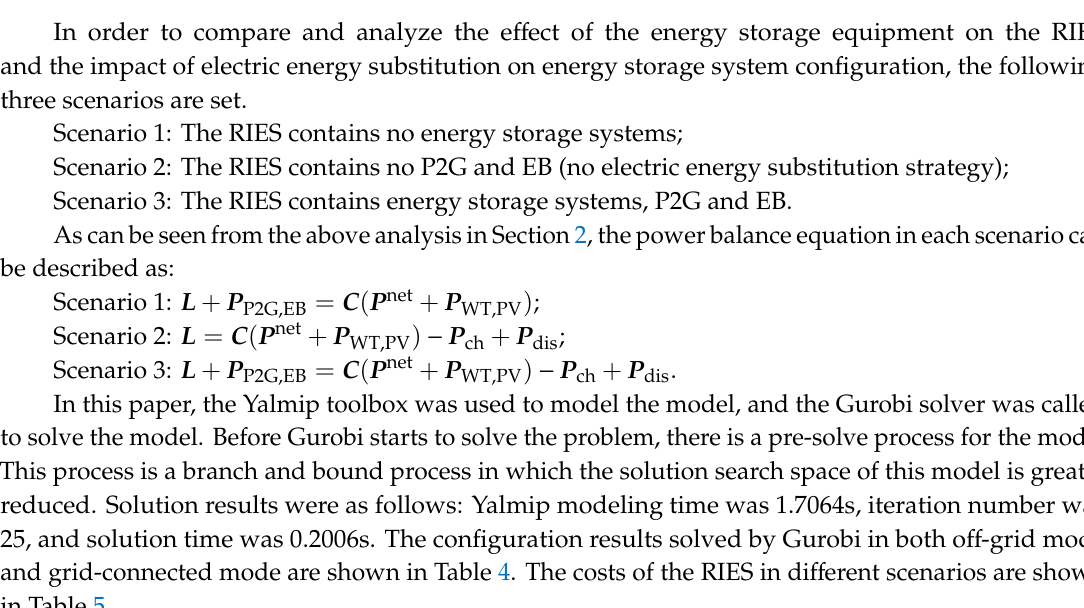
Figure 3. Load forecasting curve. 370